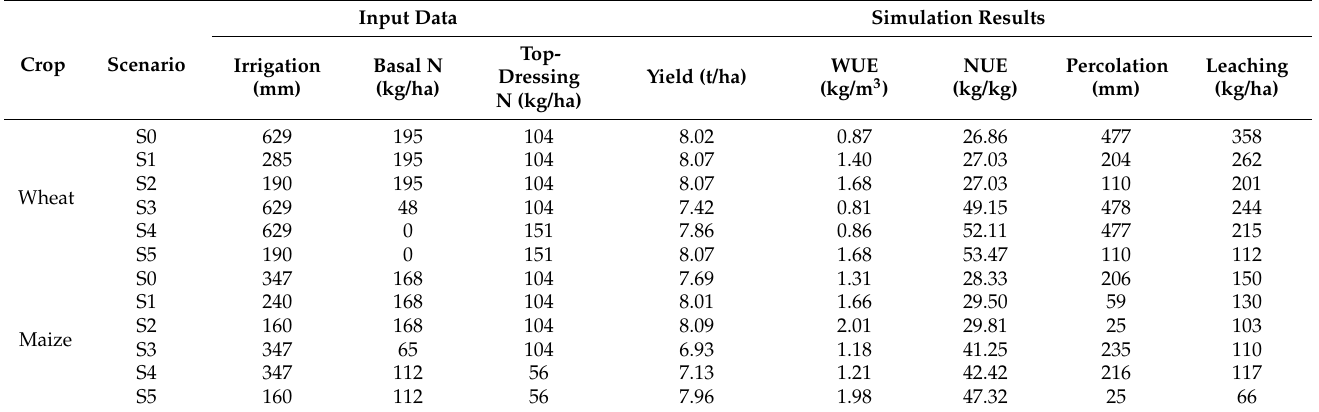
Table 5. Alternative scenarios for the reference year